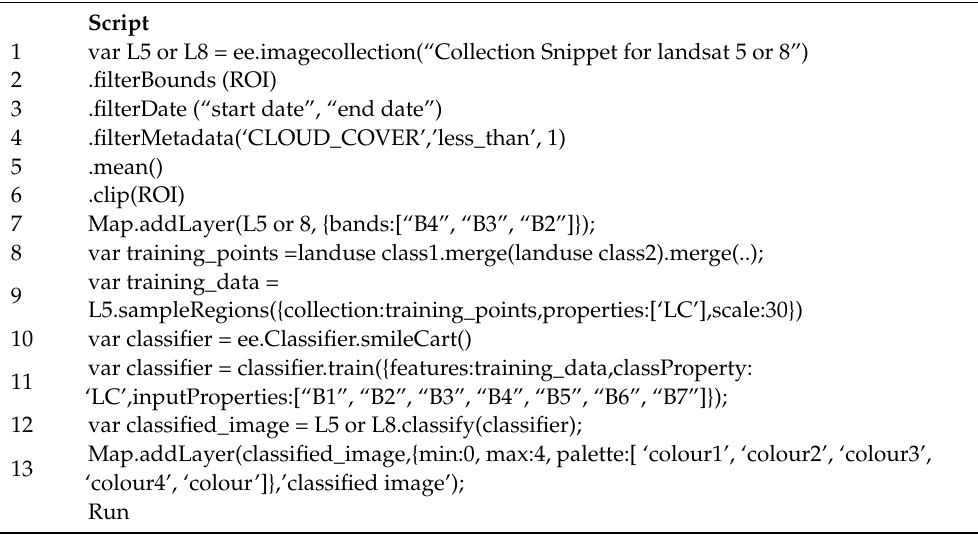
Algorithm 1: “Image retrival of Landsat 5 or 8, False color composite image preparation and LULC map preparation for 1995”